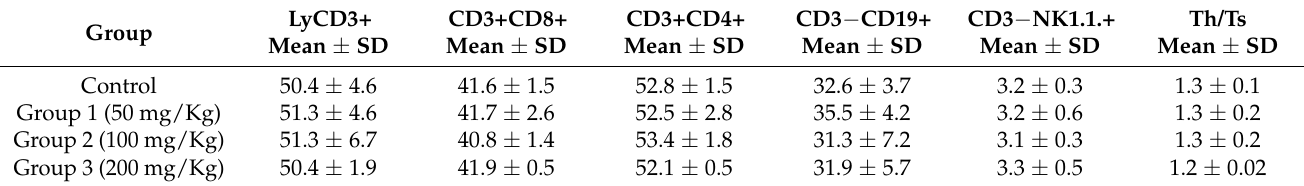
Table 11. The effect of administering ImunoBoost in three different concentrations on the lymphocyte populations and their subpopulations in mice.